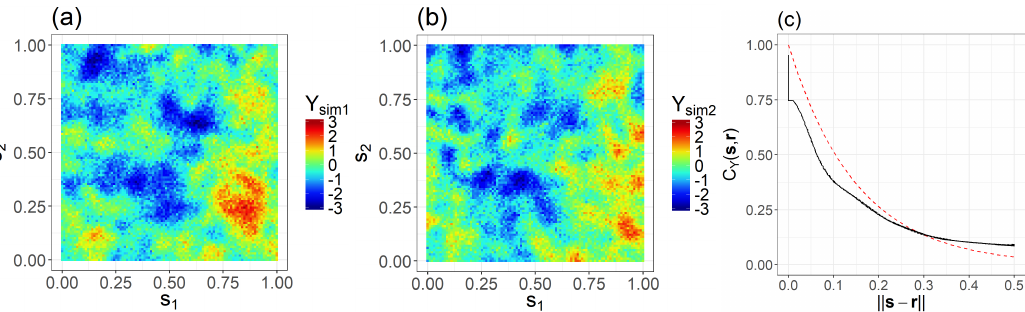
Figure 4. Conditional simulations and fitted covariance function using FRK (see the text of Section 2.3 for details). ( a ) A conditional (on the observations) simulation from the fitted model that yields FRK; ( b ) a second conditional simulation from the same model; ( c ) true stationary covariance function (red dashed line) and estimated covariance function, averaged suitably over space, that was used in FRK (black solid